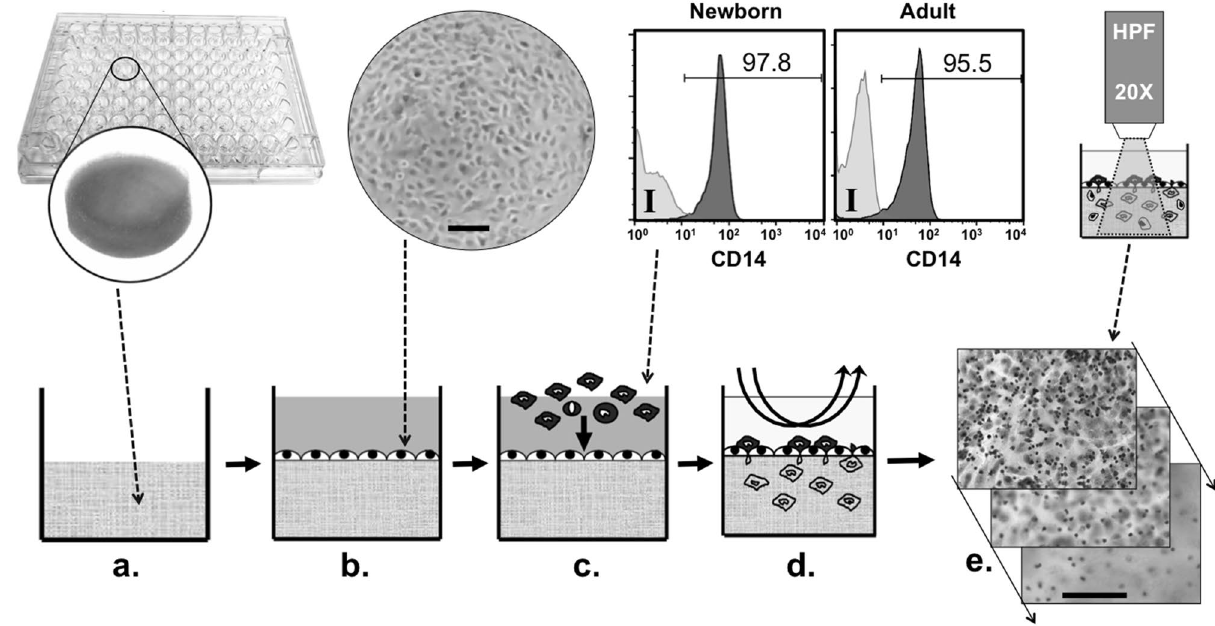
Figure 1. 3D vascular-interstitial model. ( a ) Type I collagen is cast into cushions in a 96-well microtiter plate; ( b ) Single-donor human primary endothelial cells are grown over the cushions until achieving confluency (representative image); ( c ) CD33-purified human monocytes (representative histograms for CD14 expression) are then added to confluent tissue constructs (TCs) to enable autonomous extravasation for 1.5 h at 37 °C/5%CO 2 ; ( d ) non-migrated cells are then removed by gentle aspirations; ( e ) TCs are then examined by microscopy or digested to extract extravasated monocytes for further analysis. I Isotype control. HPF High- Power Field. Scale bars = ∼ 200